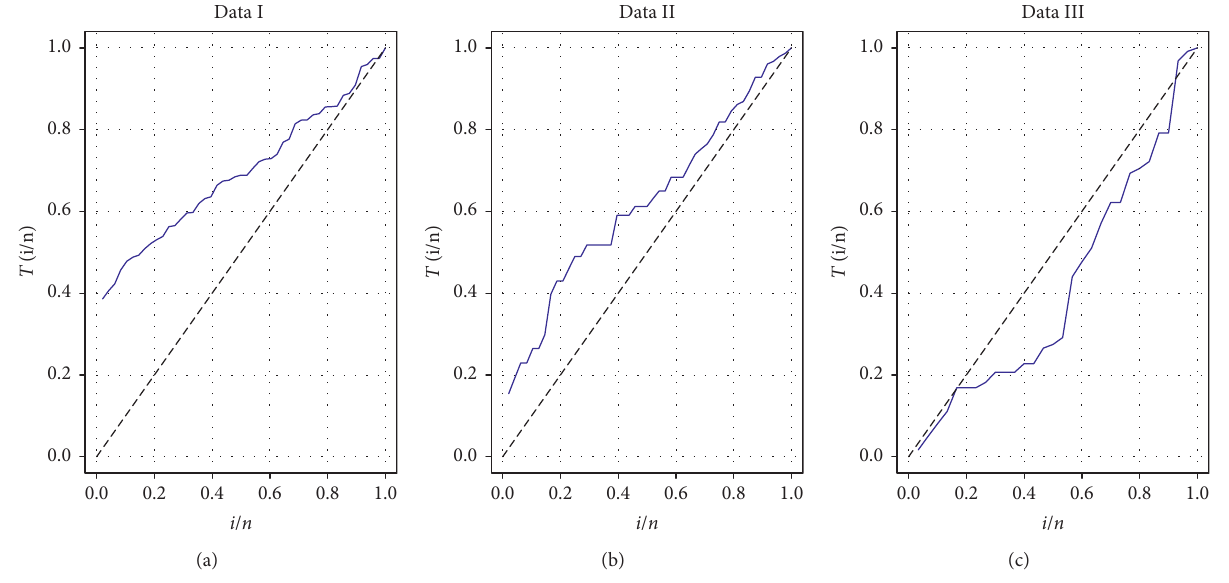
Figure 4: TTT Plots for all three data